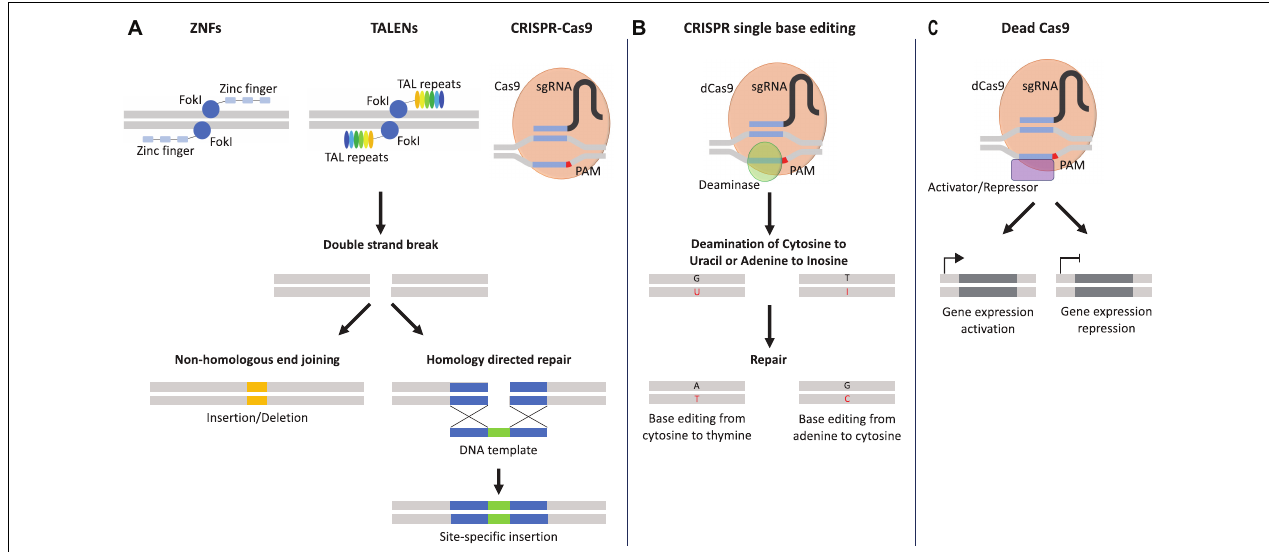
FIGURE 2 | Genome editing tools. (A) Zinc finger nucleases (ZNFs) and transcription activator-like effector nucleases (TALENs) recognize specific genomic sites with their specific DNA-binding proteins, zinc finger and transcription activator-like repeats. Clustered regularly interspaced short palindromic repeats (CRISPR-Cas9) is directed to the specific genomic site with the help of the protospacer adjacent motif (PAM) in red and the sequence of the single guide RNA (sgRNA) in blue. Once the specific genomic site is recognized, the catalytical subunits, Flavobacterium okeanokoites type IIS restriction enzyme ( Fok I), or CRISPR-associated protein 9 (Cas9) induces a double strand brake (DSB) and can be repaired either by non-homologous end joining that can lead to insertion/deletion or homology-directed repair with the help of DNA template that allows the introduction of specific mutations. (B) Catalytically inactive Cas9 or dead Cas9 (dCas9) fused to a deaminase (e.g., cytidine or adenine) can result in the conversion of cytosine–guanine base pairs to thymine–adenine or vice versa, without the need of a DSB. A = adenine, T = thymine, C = cytosine, G = guanine, U = uracil, I = inosine. (C) An additional variation of dCas9 fused to a transcriptional activator/repressor can induce transcriptional activation/repression of the targeted